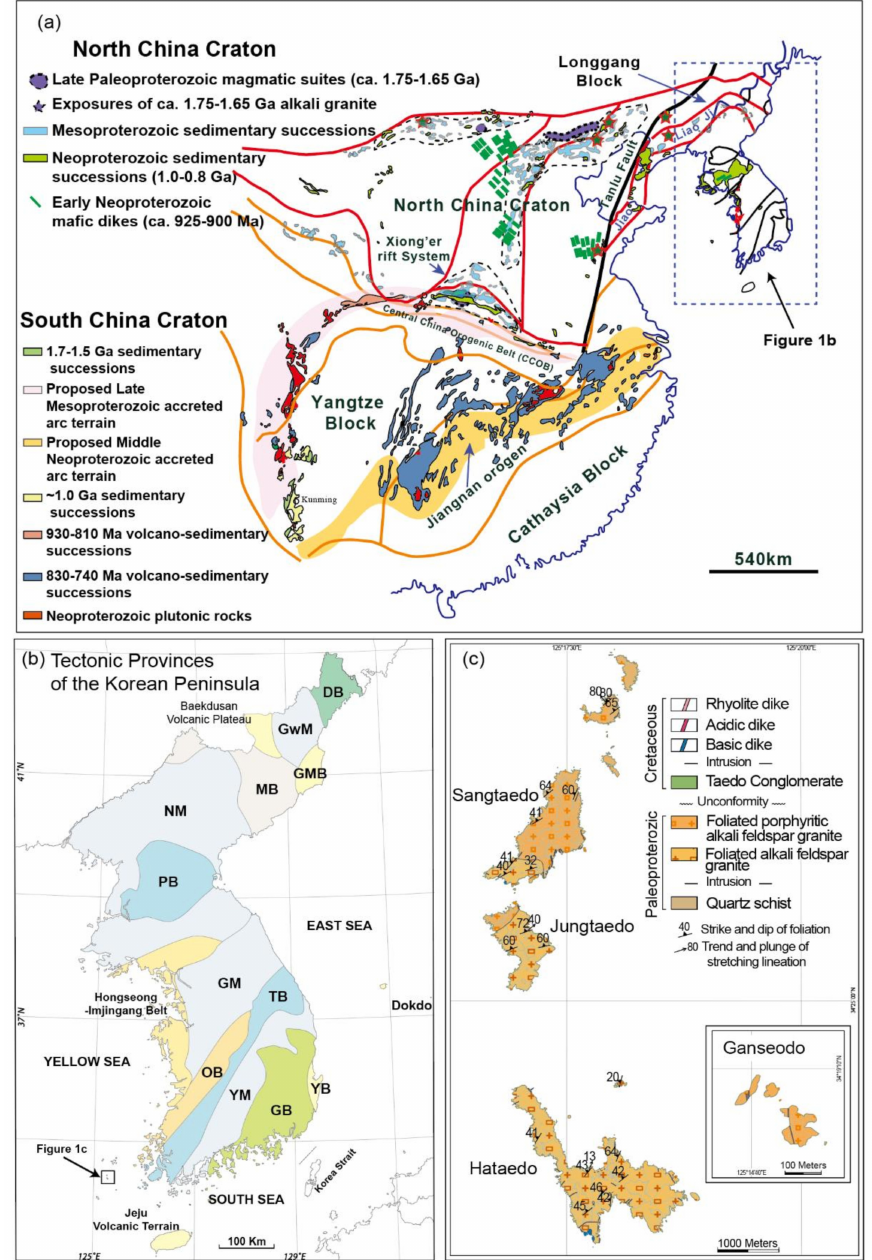
Figure 1. ( a ) Simplified tectonic map of northeast Asia (modified after [29]); ( b ) Simplified tectonic provinces of the Korean Peninsula [18]. ( c ) 1:50,000 scale Geological map of the Sangtaedo-Jungtaedo- Hataedo-Ganseodo area [17]. Abbreviations: DB—Dumangang Belt, GwM—Gwanmo Massif,